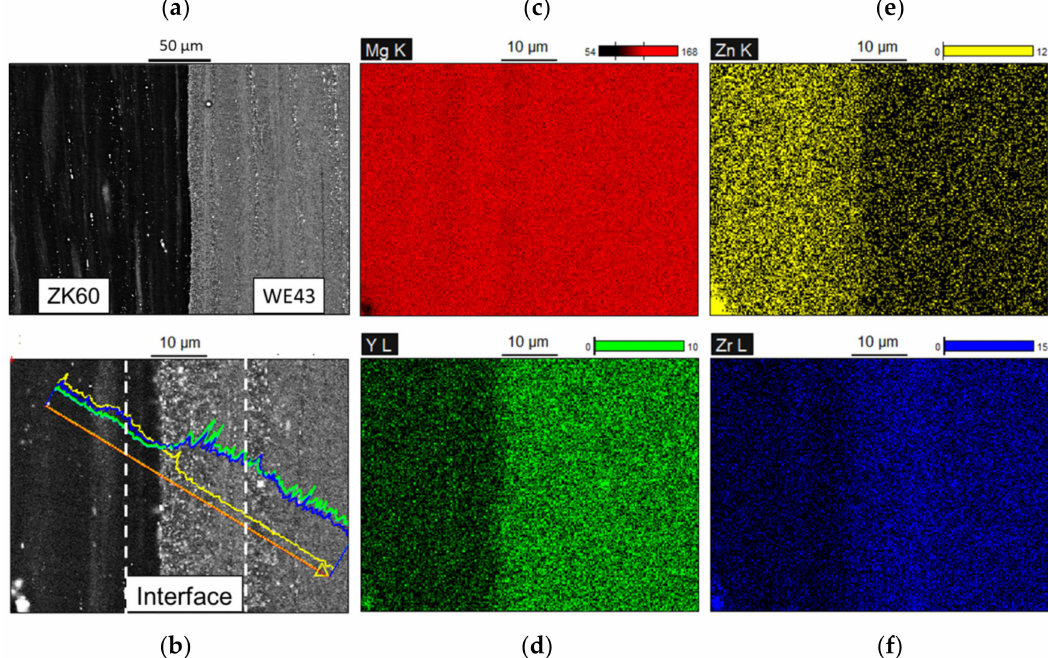
Figure 2. ( a ) Interfacial microstructure of the extruded ZK60 / WE43 rods; ( b ) higher magnification micrographs and energy dispersive X-ray spectroscopy (EDS) line analysis; mappings of ( c ) Mg, ( d ) Y, ( e ) Zn, and ( f ) Zr